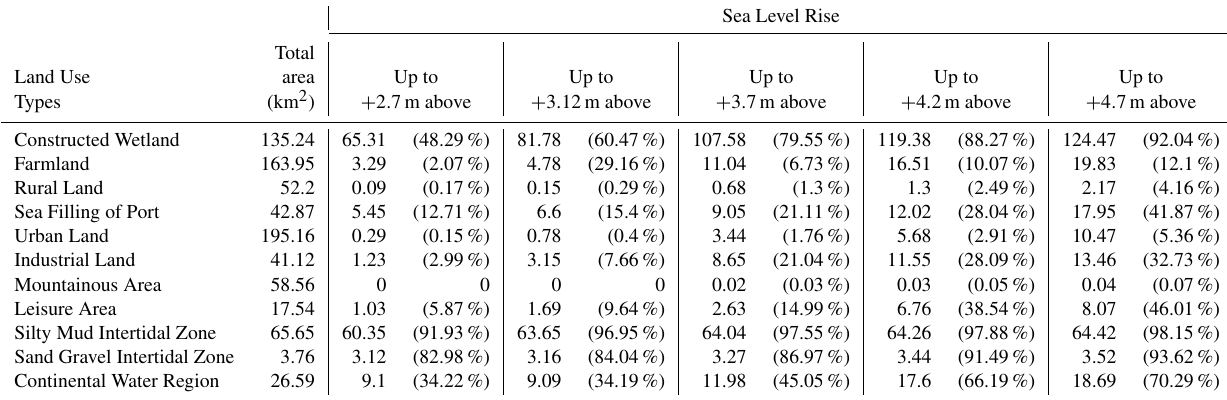
Table 4. Comparison between different